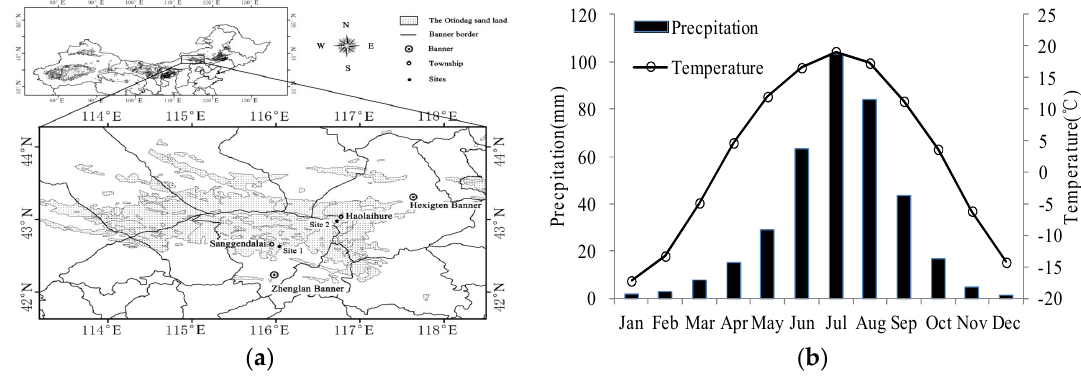
Figure 1. The location ( a ) and climate ( b ) of the study area.